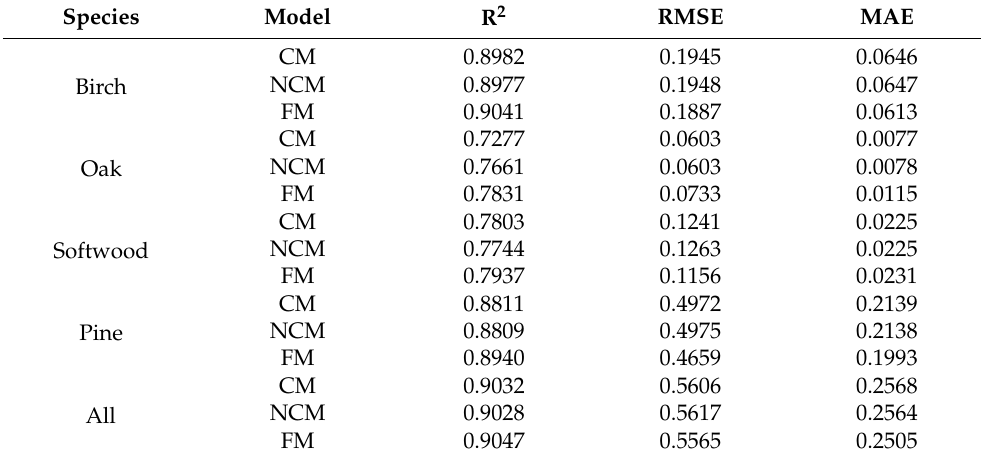
Table 8. Results of ten-fold